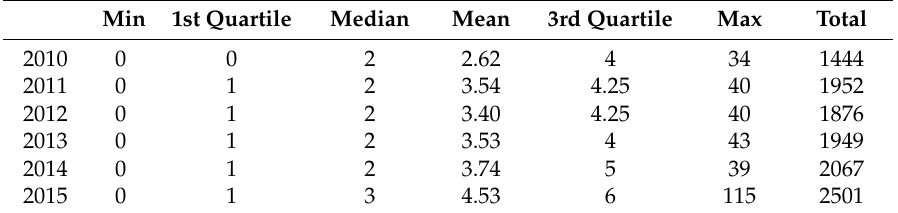
Table 2. Descriptive statistics of alcohol-related calls-for-service during the six-year period of the study. Min 1st Quartile